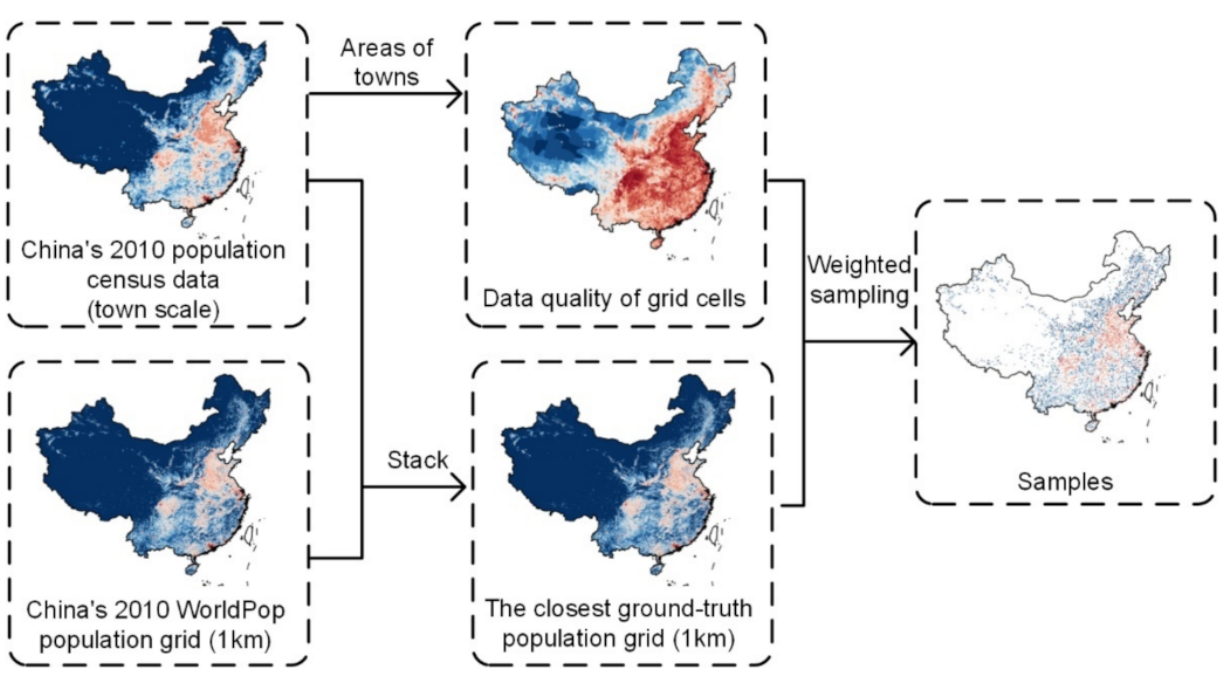
Figure 2. The flowchart of collecting the closest ground-truth population grid cell samples with a resolution of 1